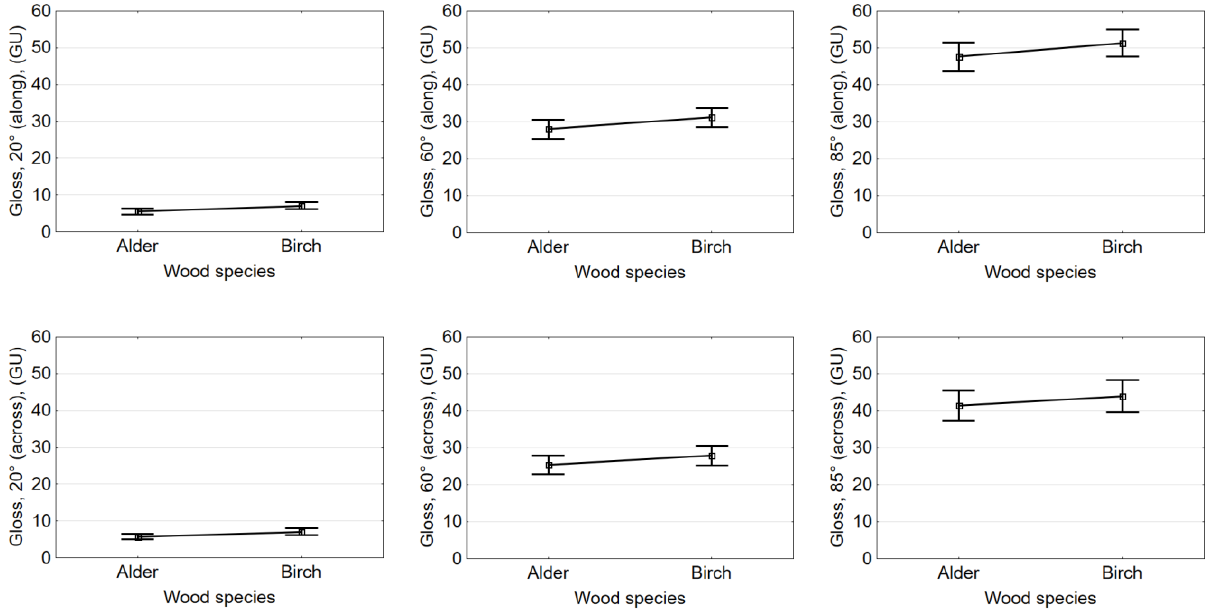
Figure 3. Main effects plot for mean gloss for different wood species for each measurement angle.